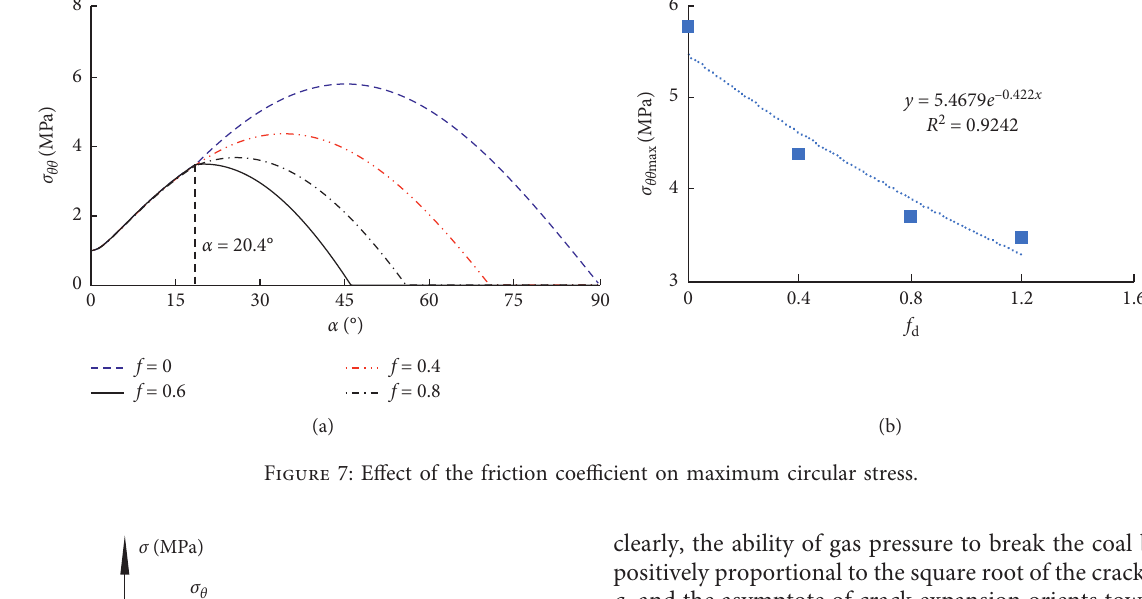
Figure 7: Effect of the friction coefficient on maximum circular stress.